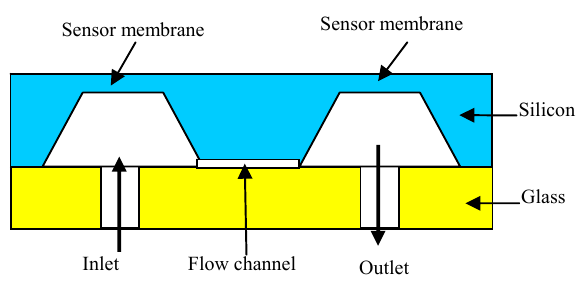
Figure 2. The layout of the sensor